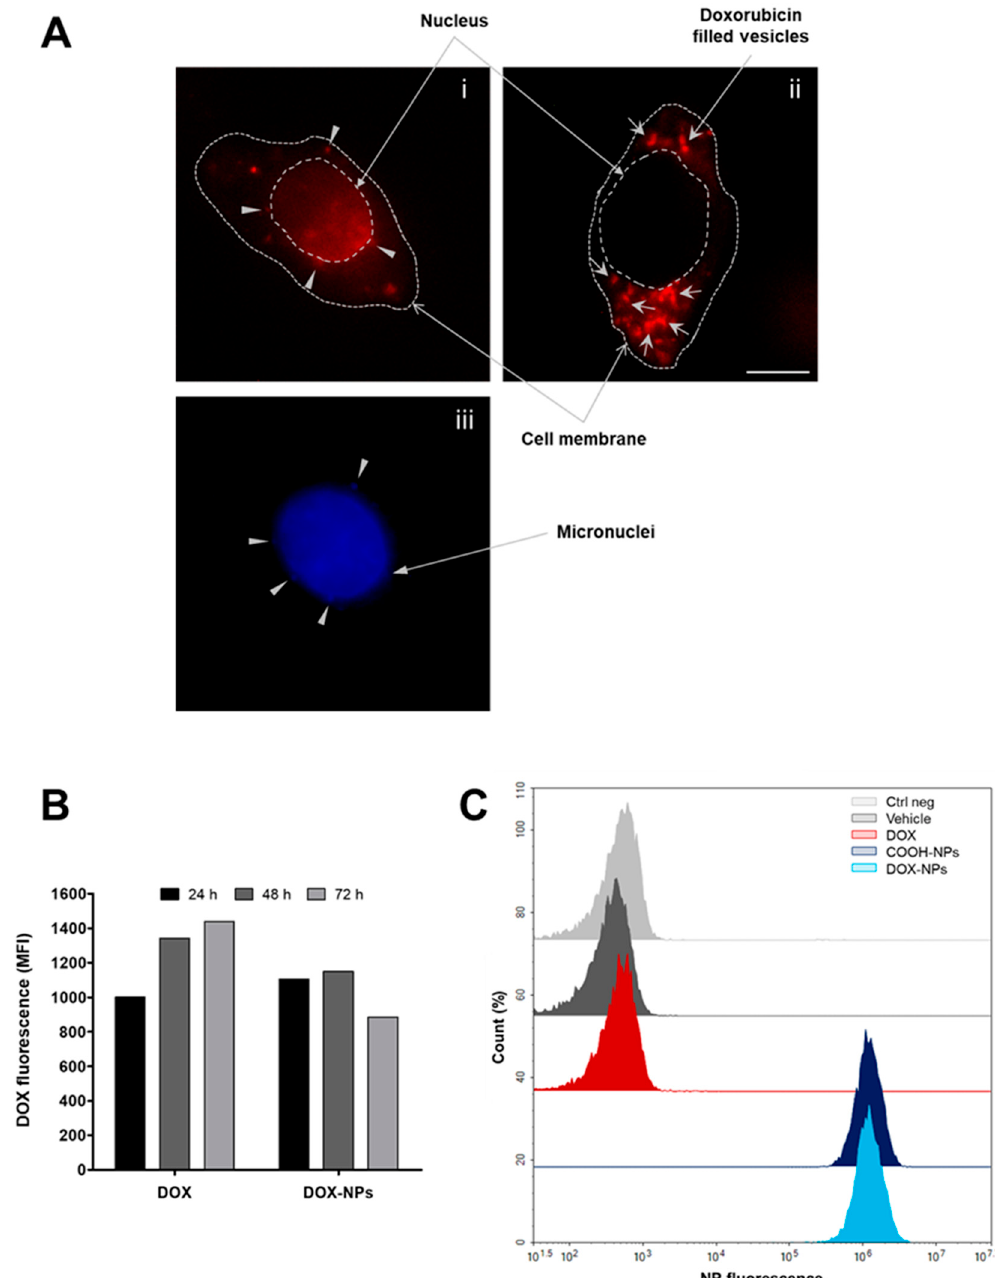
Figure 7. Intracellular accumulation and quantification of DOX in MCF-7 cells treated with DOX and DOX-NPs. MCF-7 cells were incubated with medium (Ctrl neg), DMSO (vehicle), COOH-NPs (diluted 1:50), free DOX (1 µg/mL) and DOX-NPs (1 µg/mL of DOX) for 24, 48 and 72 h at 37 °C. ( A ) Representative fluorescent microscopy images of MCF-7 cells incubated for 48 h at 37 °C with free DOX (1 µg/mL), mainly localized in the nucleus (i), and respective counter staining of nucleus with Hoechst (iii) or with DOX-NPs (1 µg/mL of drug), where red fluorescence indicates vesicles moved into the cytoplasm and perinuclear region (ii). Gray arrows highlight DOX filled vesicles, while small gray triangles indicate micronuclei containing DOX. Magnification 100× oil immersion. ( B ) Mean fluorescence intensity (MFI) of DOX from the flow cytometry data is shown as a function of time ( n = 2). ( C ) Flow cytometry histogram overlay shows the NP fluorescence within MCF-7 cells after 48 h of incubation. At least 10,000 events were analyzed by flow cytometry for each experimental condition.